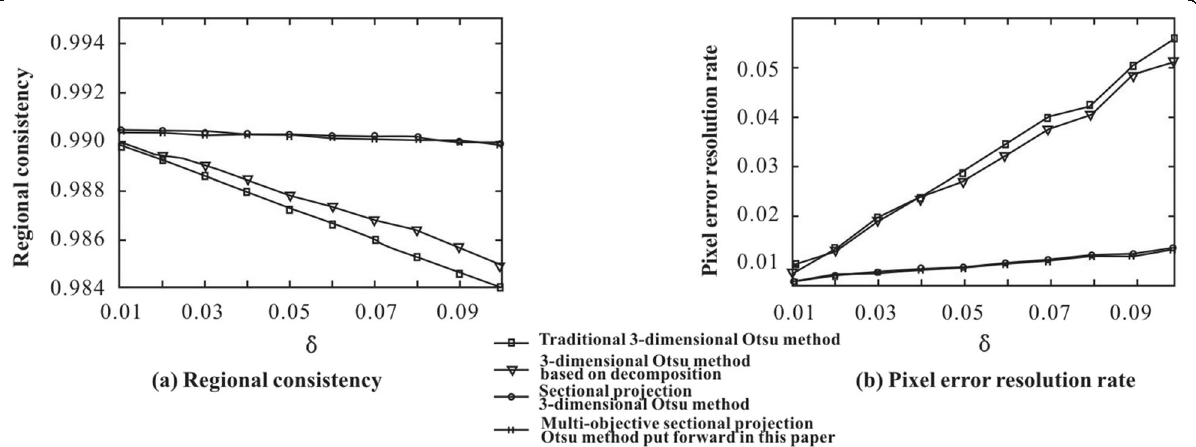
Fig. 9 Variation curve of the regional consistency and pixel error resolution rate by house increases